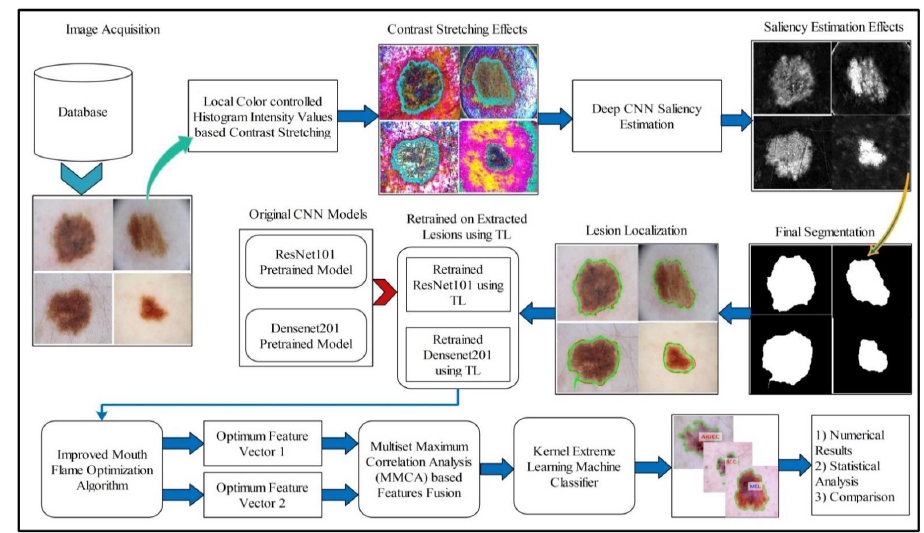
Figure 5. Proposed systematic diagram of multiclass skin lesion localization and classification.